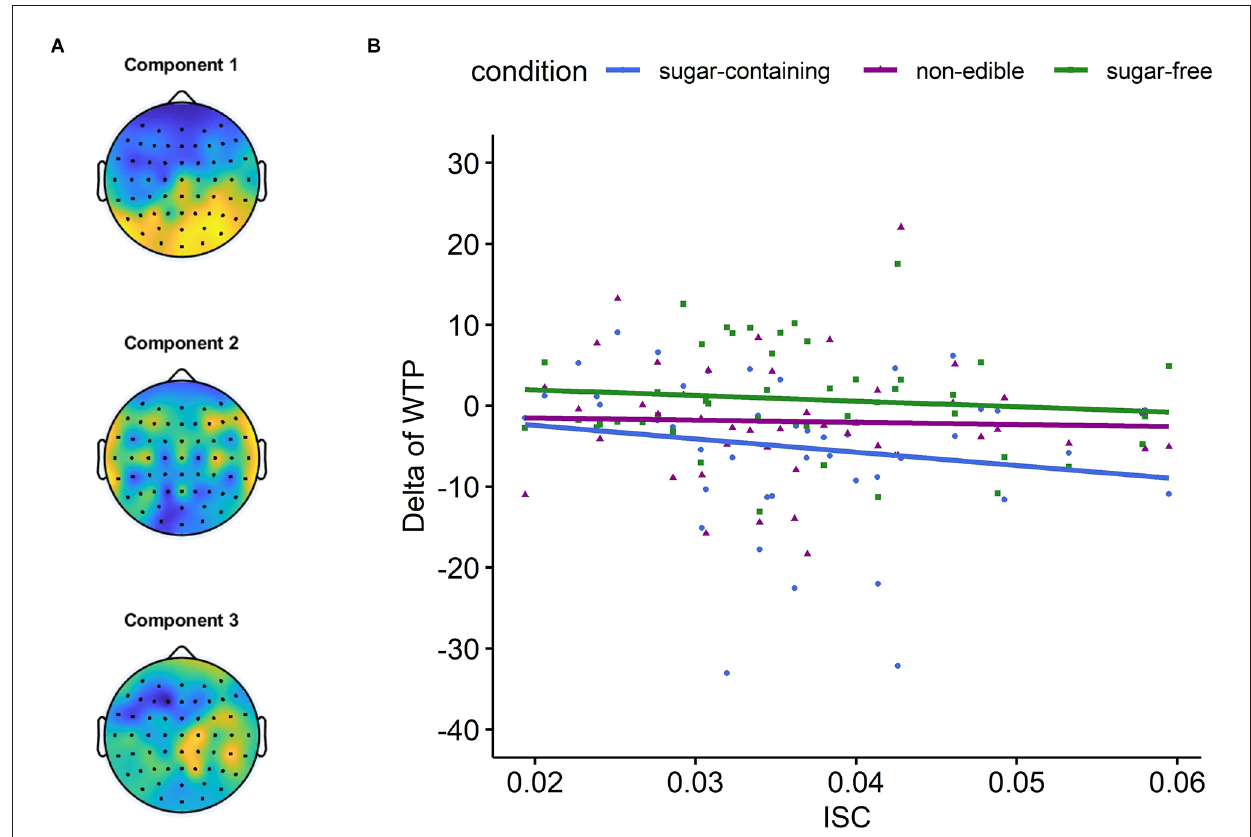
FIGURE3 The results of the intersubject correlation (ISC) analysis. (A) Scalp projections of the three strongest correlated components. (B) The relationship between the ISC during listening to the healthy eating call and the delta of WTP for different product categories. For the category of sugar-containing products, the correlation was r = − 0.29, with a one-tailed p -value =